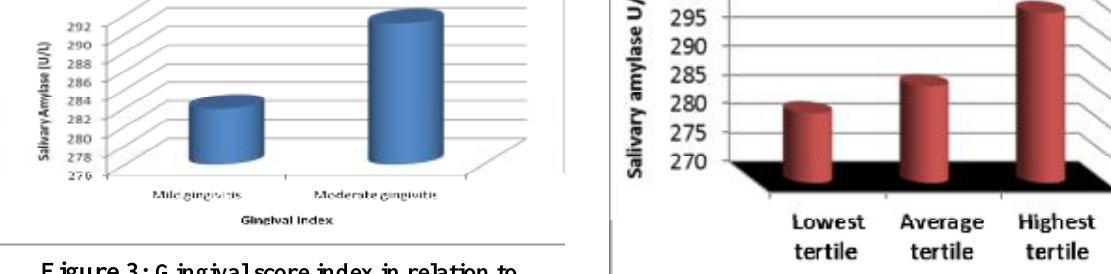
Figure 3: Gingival score index in relation to mean salivary amylase